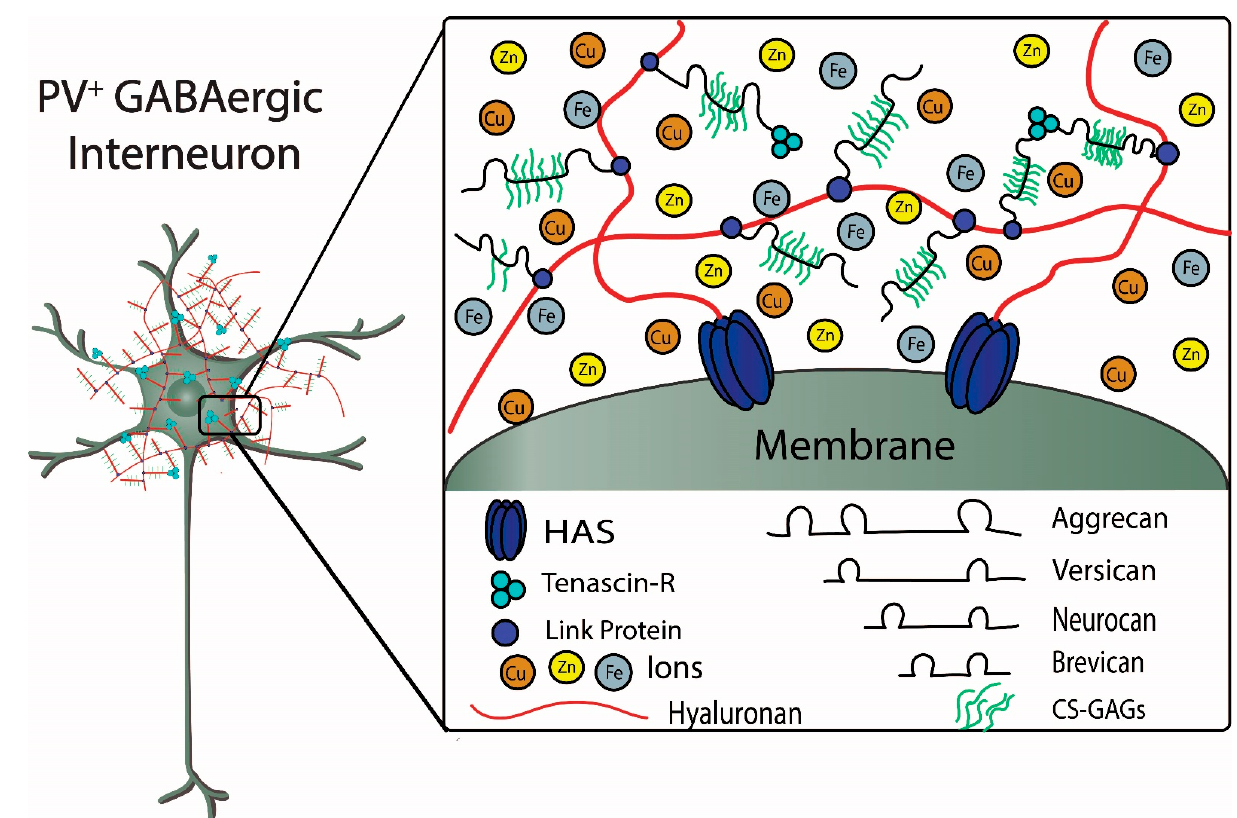
Figure 2. Components of the perineuronal net (PNN) and interaction with metal